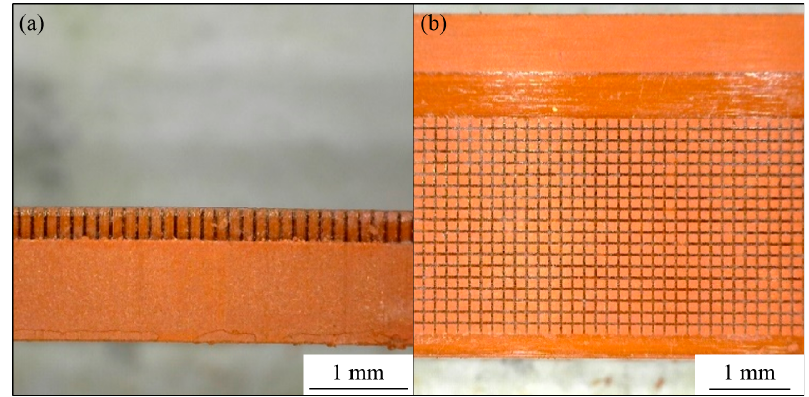
Figure 6. Injected specimen attached with PMMA sacrificial mold: ( a ) side view; ( b ) top view.